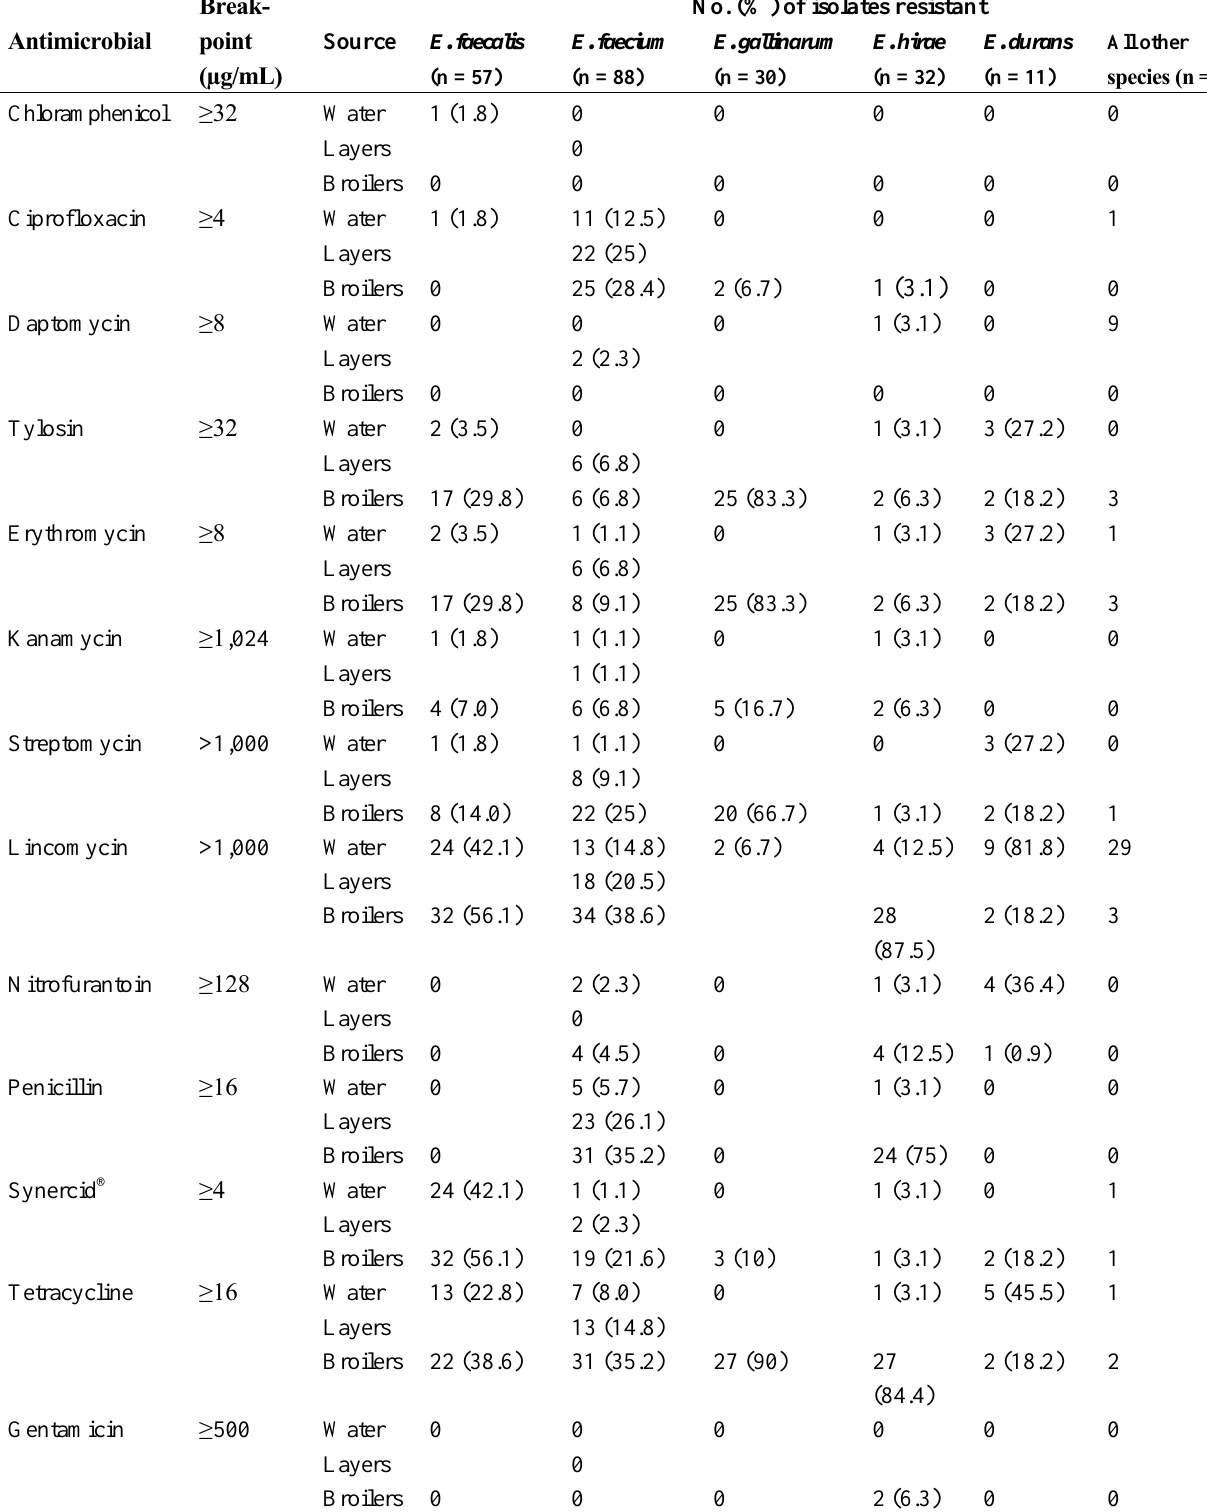
Table 2. Antimicrobial resistance profiles of enterococci from surface water and poultry litter samples from both broiler and layers